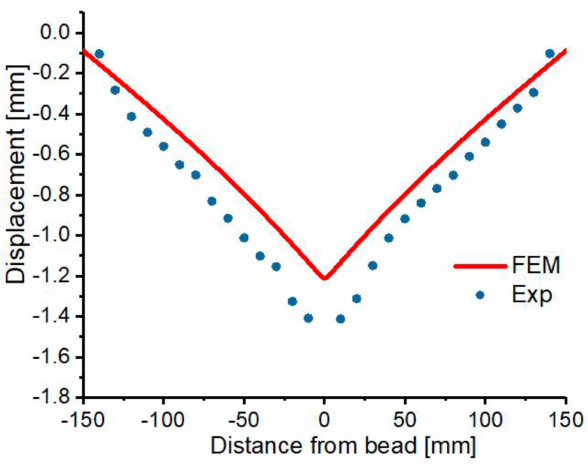
Figure 17. Compared welding